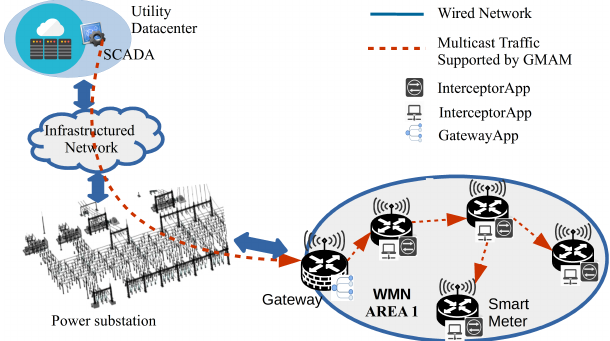
Figure 3. Components of GMAM platform and where it takes